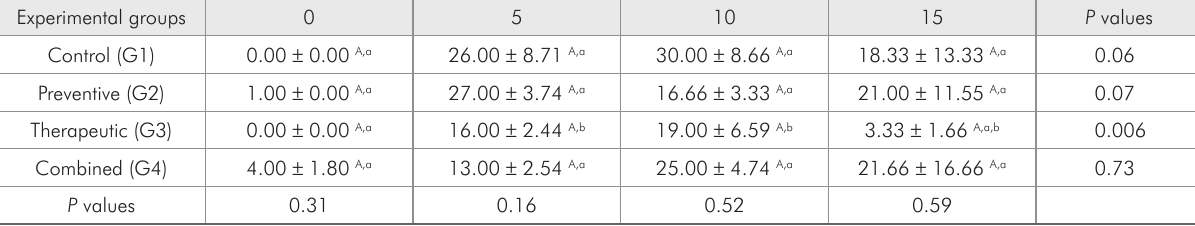
Table 1 - Mean ± standard deviation of weight losses (g) in different groups at different evaluation times (days). Experimental groups